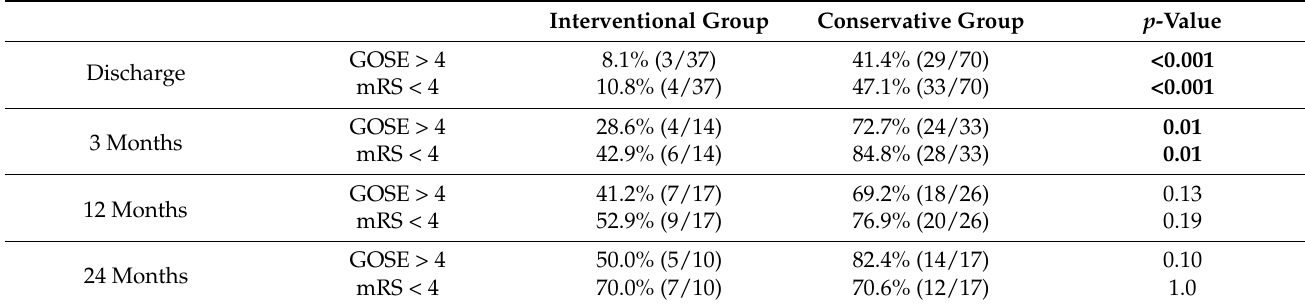
Table 2. Functional outcome assessed by GOSE and mRS. GOSE: Extended Glasgow Outcome Scale; mRS: modified Rankin Scale. A GOSE score of five or better indicates independence at home but inability to return to work. An mRS score of three or less indicates the ability to walk without assistance but requiring some help with daily